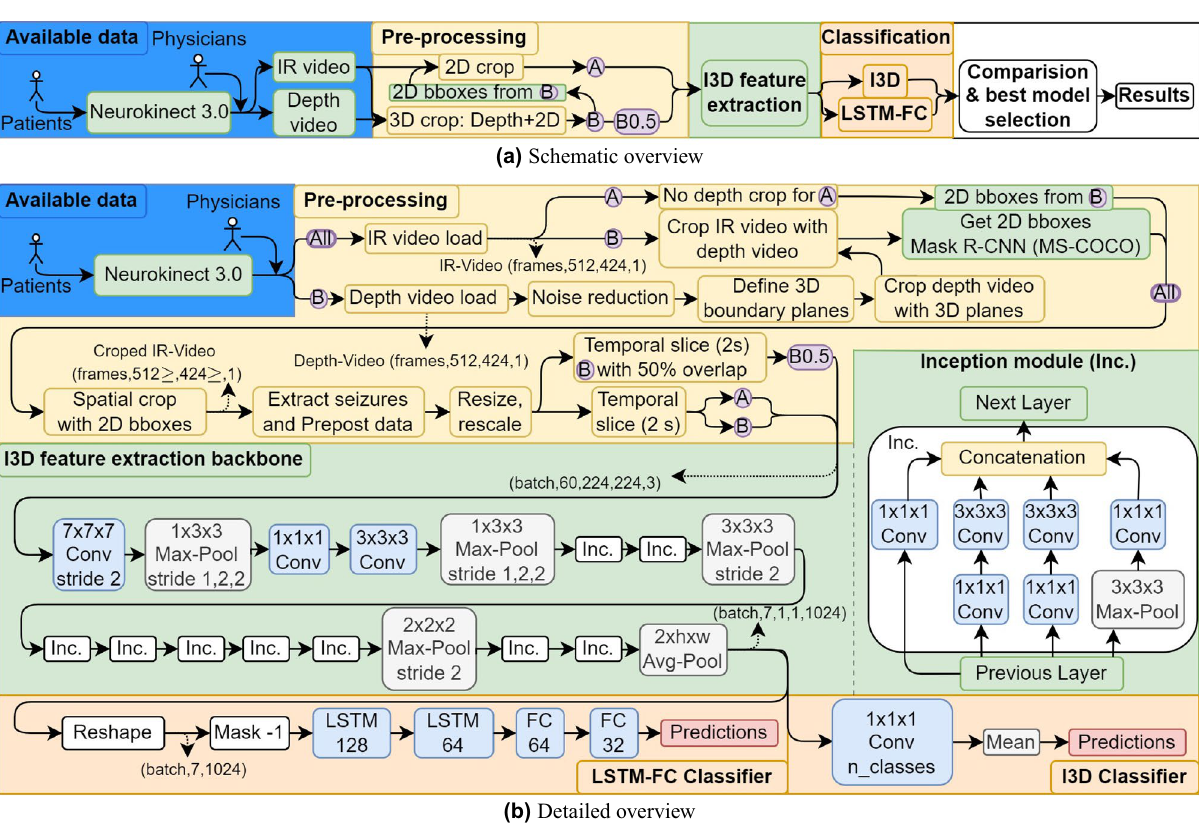
Figure 3. ( a ) Schematic overview of the architecture pipeline, and ( b ) detailed overview including the available data from Neurokinect 3.0 21 , the pre-processing algorithm for all 3 datasets, (A–2D (Mask R-CNN) cropping with bounding boxes of B; B–2D and depth cropping; B0.5–B with 50% overlapping 2s temporal slices, see “Data pre-processing”), the I3D feature extraction backbone 24 (see “Feature extraction”) and the LSTM-FC and